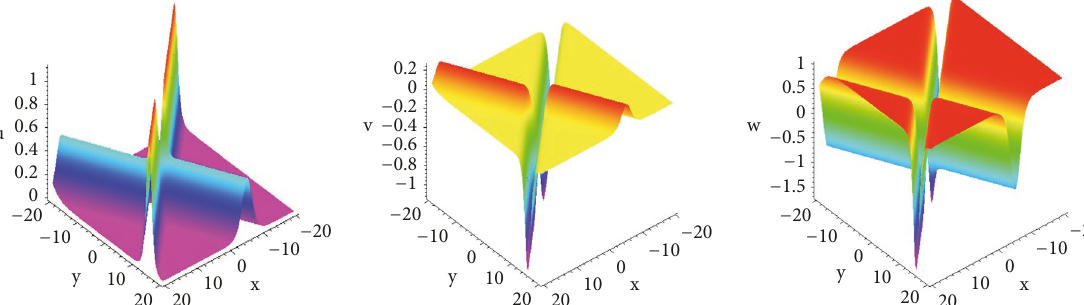
Figure 2: Three interactions of two-resonant solitons expressed by (29) for the solution of (2) and (3) with the parameters 𝛼,𝛽, 𝛾,𝜀, 𝑎, 𝑐 1 , 𝑐 2 ,𝑘 1 are all taken 1 , but 𝑙 1 = 1/2, 𝑘 2 = −𝑙 2 = 3/2